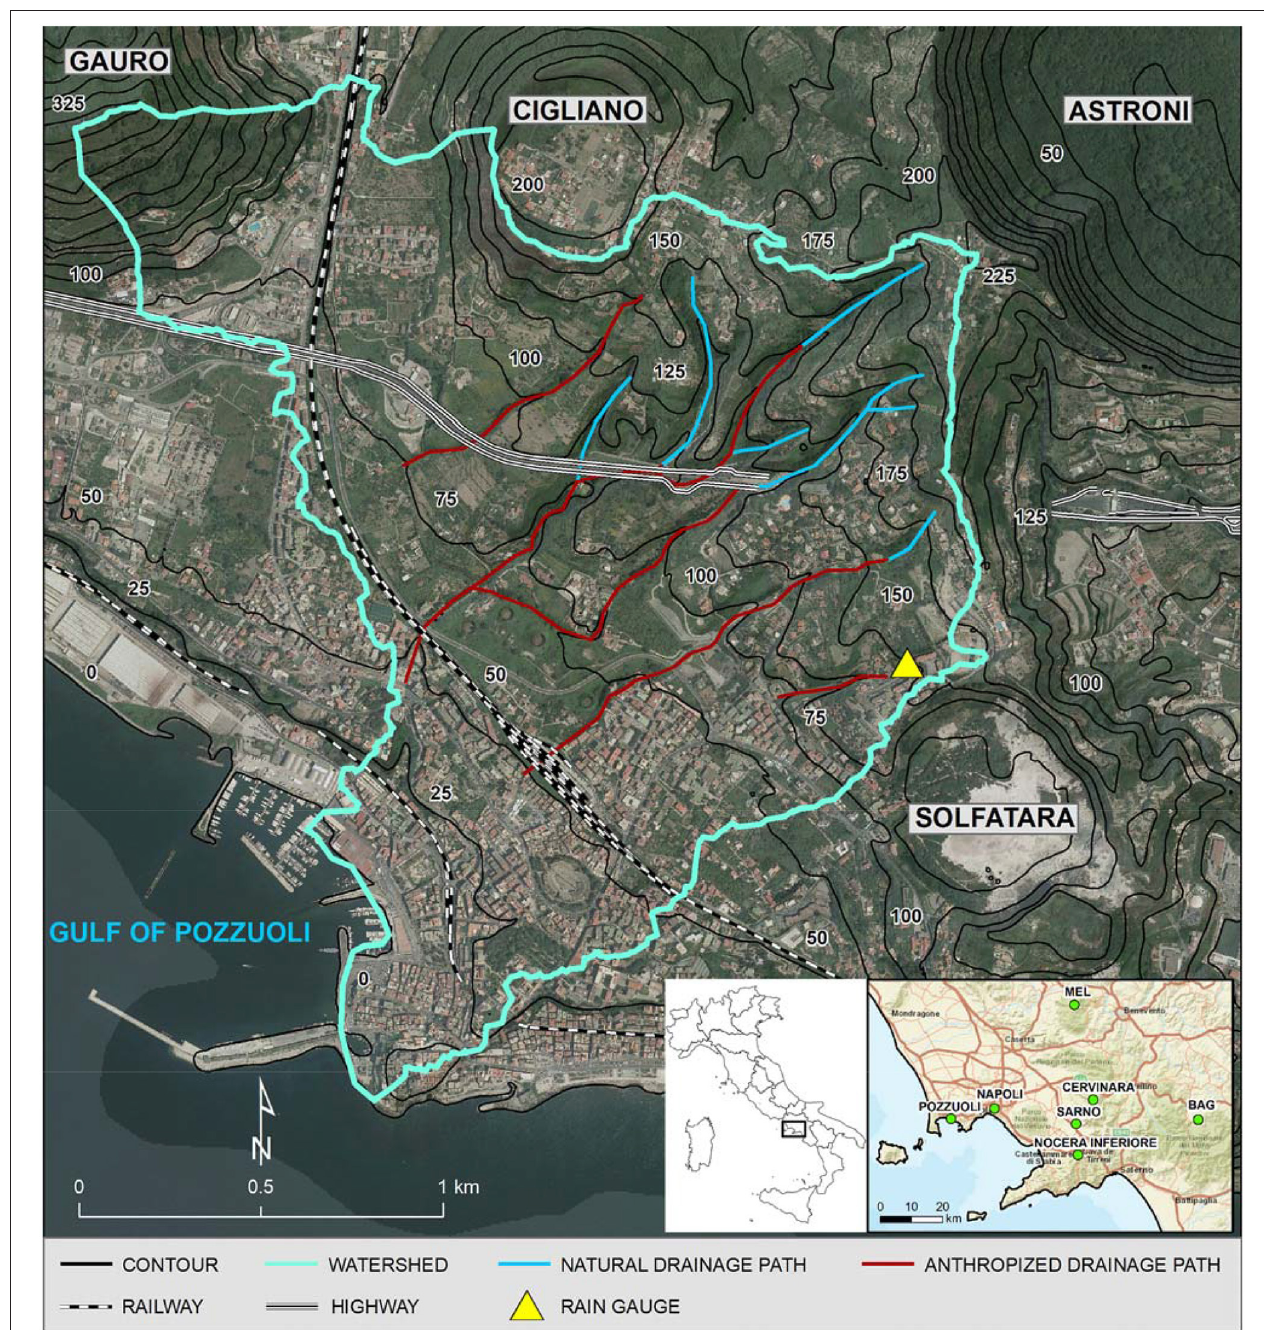
FIGURE 1 | Aerial view and location of the Pozzuoli town within the Campania Region, southern Italy. The most important infrastructures and position of the rain gauge are also indicated. The contour interval is 25m.